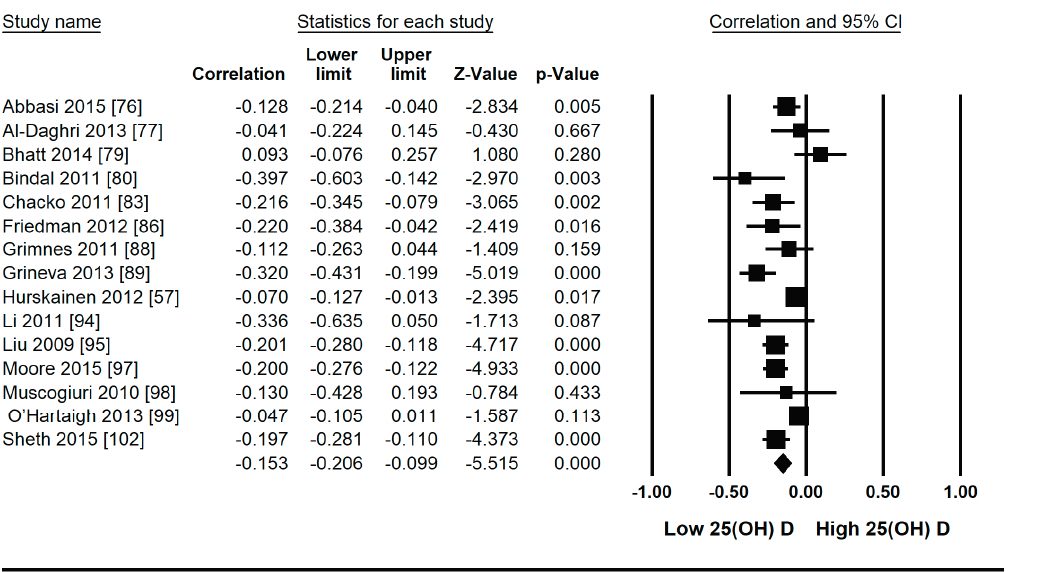
Figure 8. Forest plot for the medium BMI quartile (25–30) of non-diabetic subject studies showing the correlation between the status of vitamin D and fasting plasma insulin. The random effects model was used for the determination of correlation and 95% CI [57,76,77,79,80,83,86,88,89,94,95,97–99,102].